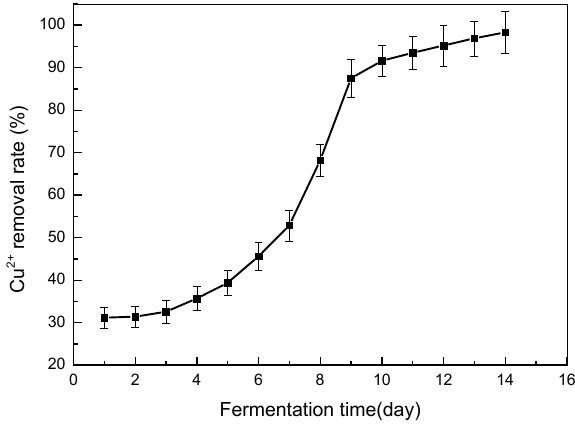
Figure 7: Effect of fermentation time on the copper ions removal rate (The initial content of copper ions was 100 mg/L. 0.2 g of the adsorbent was used).